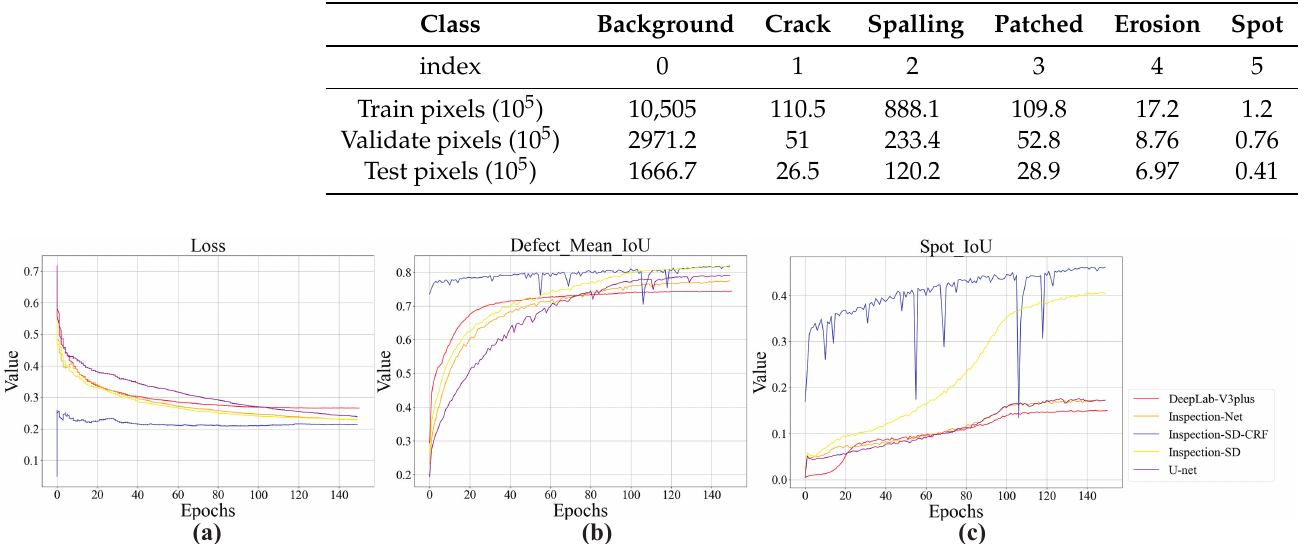
Table 1. Number of class pixels statistic in DSI and CSSC.